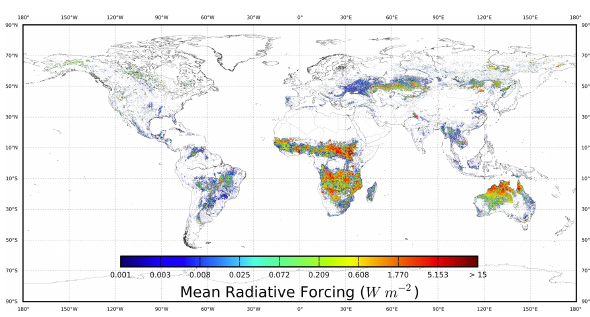
Figure 1. Global mean radiative forcing caused by “instantaneous” shortwave albedo changes in areas affected by fires during 2002– 2012. The values were normalized using a logarithmic scale.